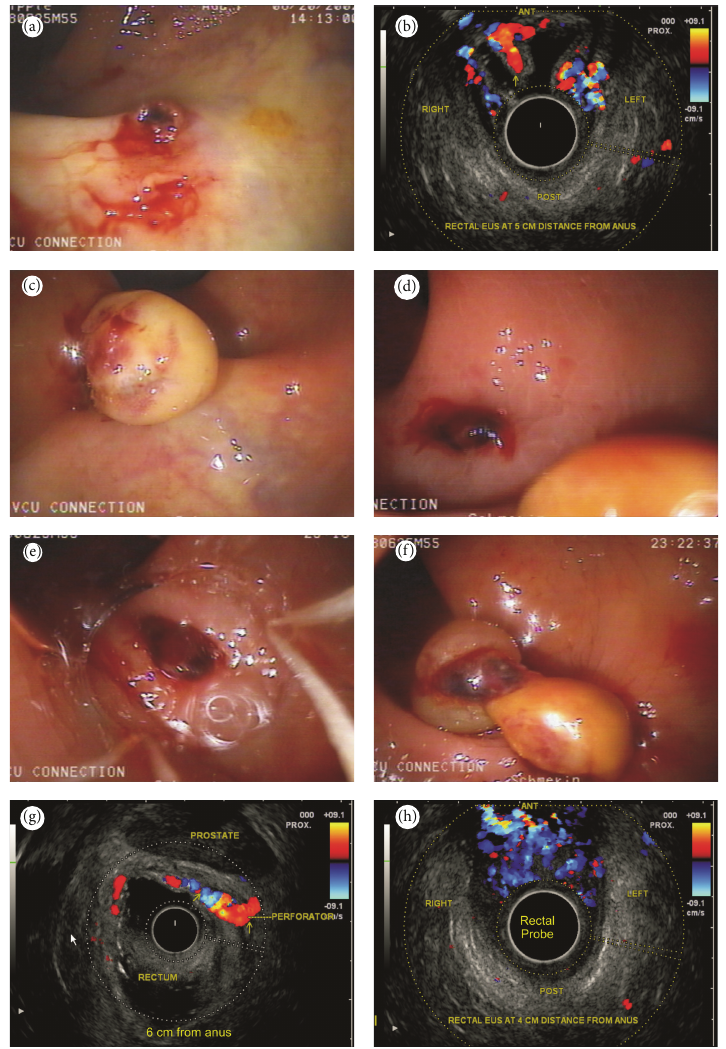
Figure 4: (a) An ulcer covered by a clot gives appearance of Dieaulafoy’s ulcer. Clot could not be removed by flushing. (b) At about 6 cm distance in rectum inflowing perforators were noted in the submucosa of rectum. No pararectal varices were seen. (c) A band is applied on the clot as rectal varices were demonstrated by EUS under the ulcer. (d) The bleed stopped but after 24 hours patient rebleeds from a fresh point above the previously banded ulcer. (e) The new point of bleeding is caught inside the band. (f) Two bands are seen applied separately. (g) An inflowing perforator of the diameter of 3mm is seen coming from the lateral wall of rectum before banding. (h) The diameter of rectal varices became smaller and more numerous as they were followed downwards the anorectal junction. At 4 cm distance the rectal varices are seen going towards the prostate.